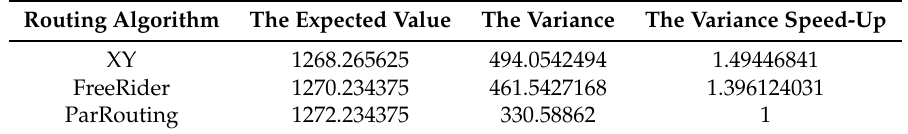
Figure 9. Performance on a 4 × 4 2D Mesh network for synthetic traffic patterns. For each traffic pattern, the results of the four routing algorithm implementations considered in this work are described. Deterministric routing (XY), local congestion-aware routing (DyXY), regional congestion-aware routing (FreeRider), and our Area Partition-based routing (ParRouting). ( a ) bit_reverse. ( b ) bit_rotation. ( c ) shuffle. ( d ) transpose. ( e ) uniform_random. Table 1. The expected values, variance and variance speed-up of crossbar activity corresponding to Figure 10. Routing Algorithm The Expected Value The Variance The Variance Speed-Up